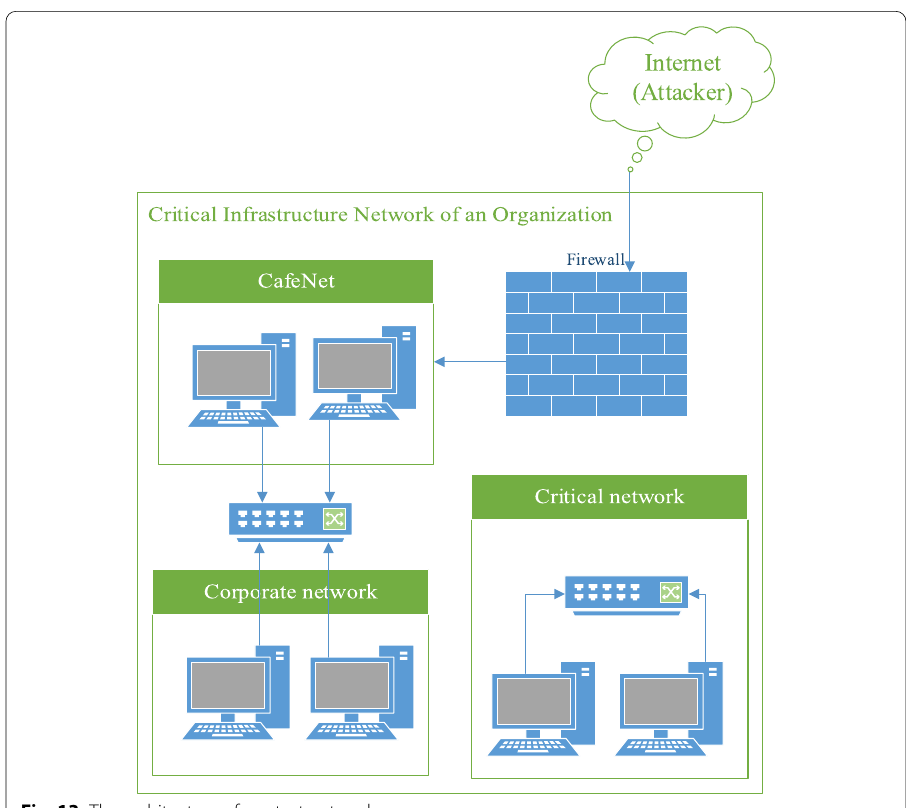
Fig. 13 The architecture of our test